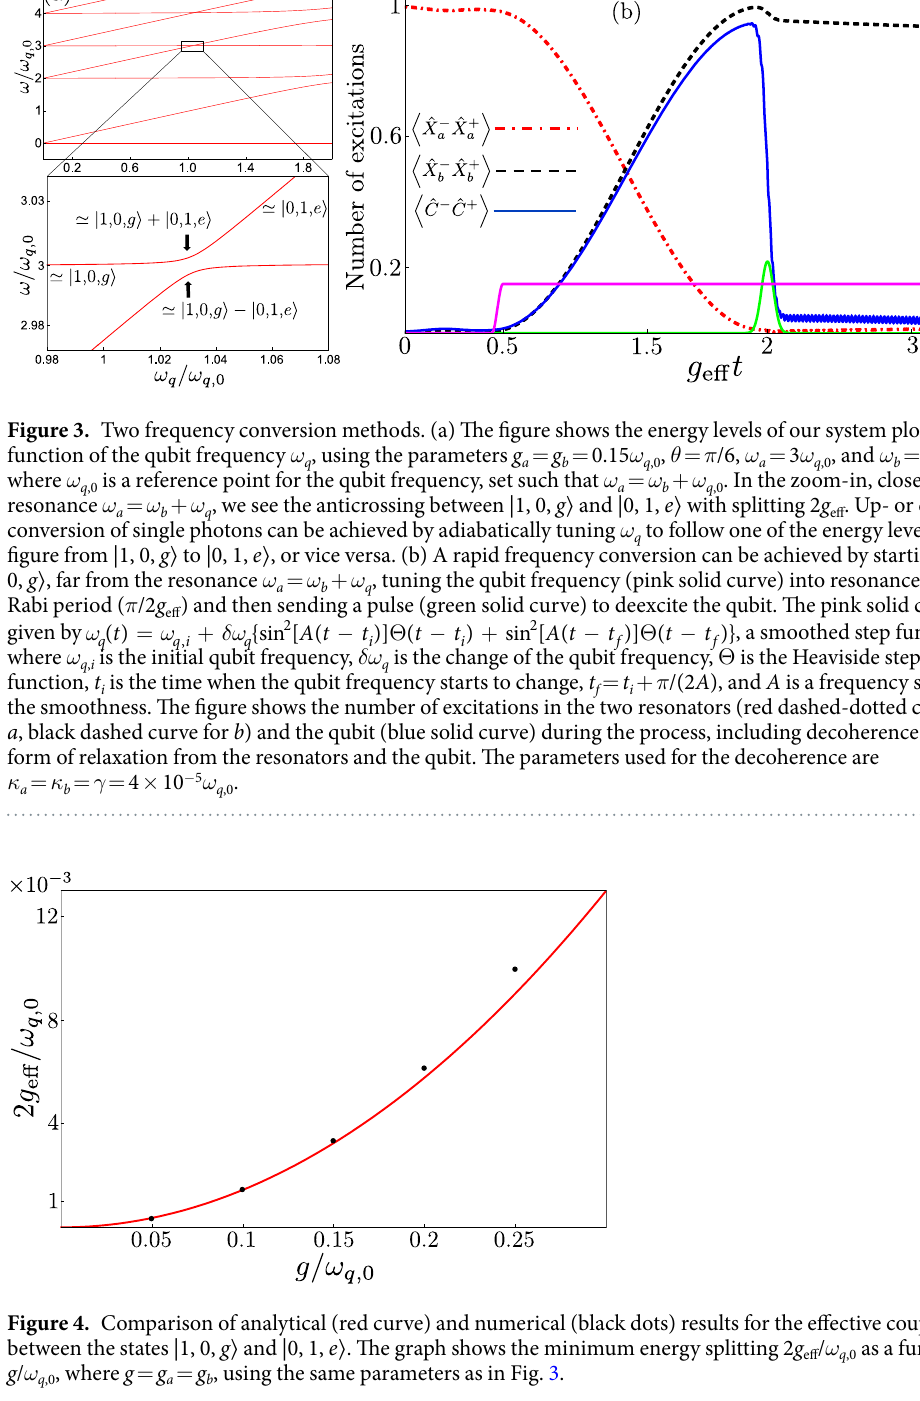
above, there are now two possibilities for how the qubit state can change during the conversion process. Below, we will study both |1, 0, g 〉 ↔ |0, 2, e 〉 and |1, 0, e 〉 ↔ |0, 2, g 〉 . Since we wish to use the qubit to control the process, we do not consider the process |1, 0, g 〉 ↔ |0, 2, g 〉 , which to some extent was already included in ref. 80, although that work considered a setup with ω q ≈ ω b and mainly studied the squeezing produced by a strong external drive. The |1, 0, g 〉 ↔ |0,2, e 〉 process. For the process |1, 0, g 〉 ↔ |0, 2, e 〉 , we first of all note one more difference compared to the single-photon frequency conversion case: it changes the number of excitations from 1 to 3, which means that excitation-number parity is conserved. This makes the longitudinal coupling of Eq. (1) redundant for achieving the conversion, and to simplify our calculations we therefore hereafter work with the standard quantum Rabi Hamiltonian 98 extended to two resonators,